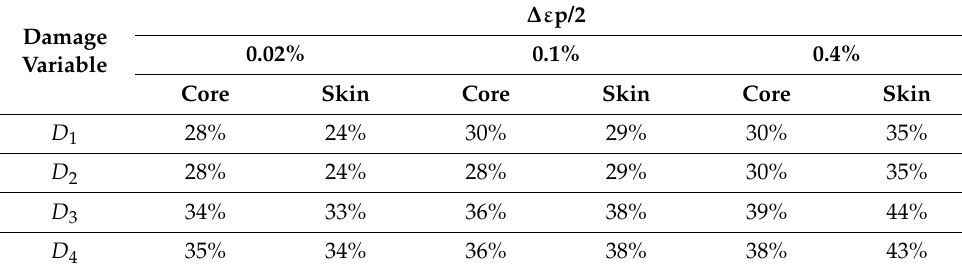
Table 10. Damage measurements on fatigue specimens fracture surfaces.